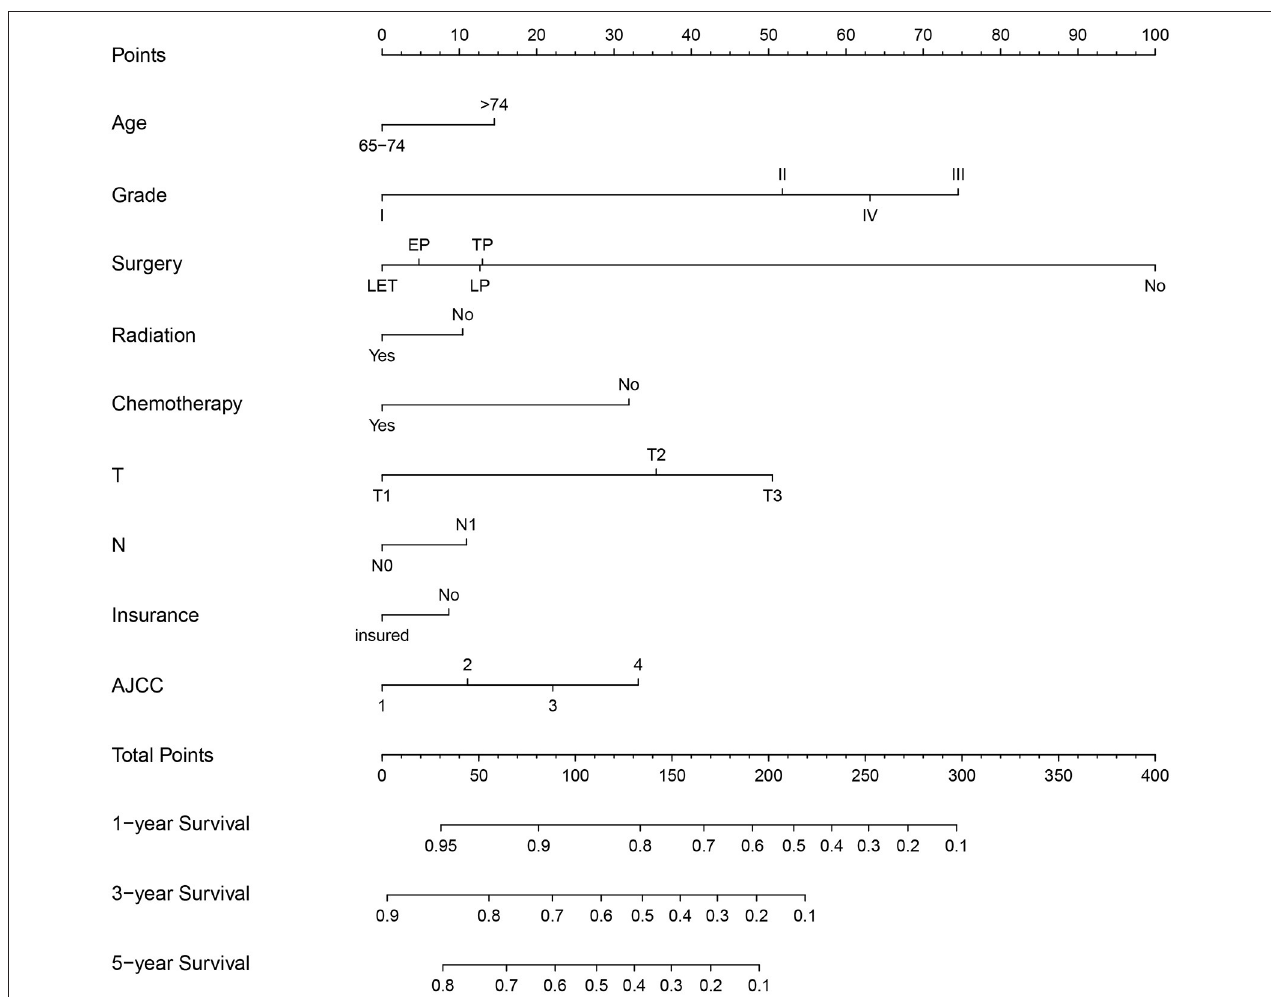
FIGURE 2 | Nomogram for 1-, 3-, and 5-year OS of elderly patients with